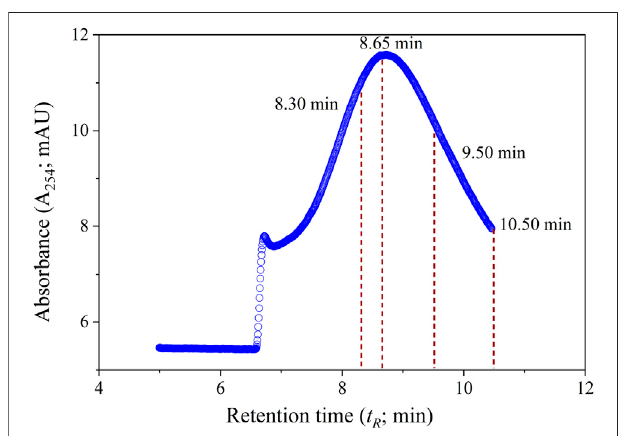
FIGURE2| ThefractogramoftheDOMsamplecollectedattheeastside of the T1 transect (T1E), showing four stopping points ( t R ≈ 8.30, 8.65, 9.50, and 10.50 min) for online size-resolved EEM measurements in this